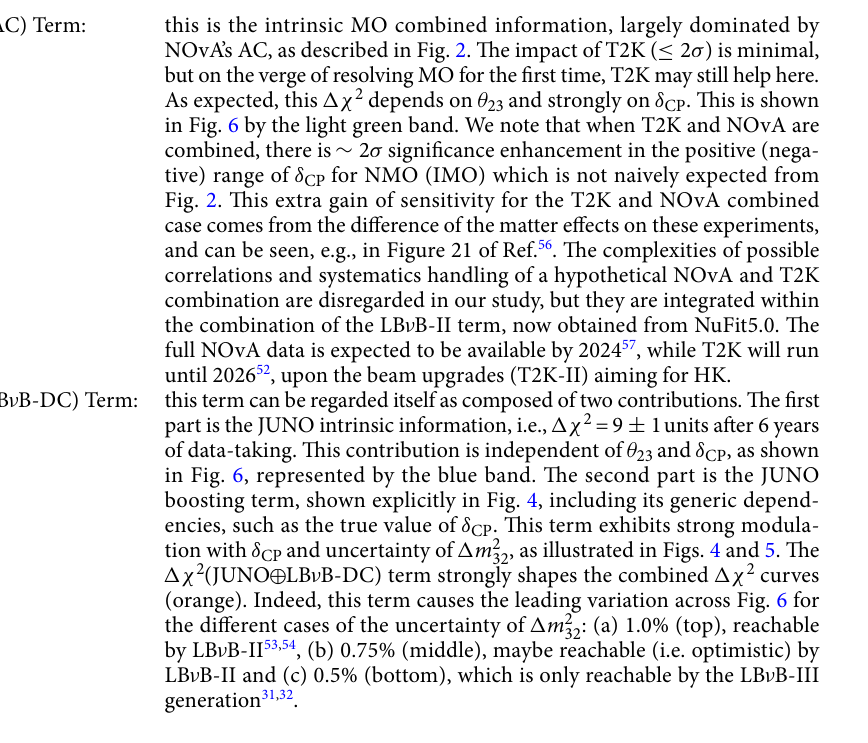
this is the intrinsic MO combined information, largely dominated by NOvA’s AC, as described in Fig. 2. The impact of T2K ( ≤ 2 σ ) is minimal, but on the verge of resolving MO for the first time, T2K may still help here. As expected, this �χ 2 depends on θ 23 and strongly on δ CP . This is shown in Fig. 6 by the light green band. We note that when T2K and NOvA are combined, there is ∼ 2 σ significance enhancement in the positive (nega- tive) range of δ CP for NMO (IMO) which is not naively expected from Fig. 2. This extra gain of sensitivity for the T2K and NOvA combined case comes from the difference of the matter effects on these experiments, and can be seen, e.g., in Figure 21 of Ref. 56 . The complexities of possible correlations and systematics handling of a hypothetical NOvA and T2K combination are disregarded in our study, but they are integrated within the combination of the LB ν B-II term, now obtained from NuFit5.0. The full NOvA data is expected to be available by 2024 57 , while T2K will run until 2026 52 , upon the beam upgrades (T2K-II) aiming for HK.